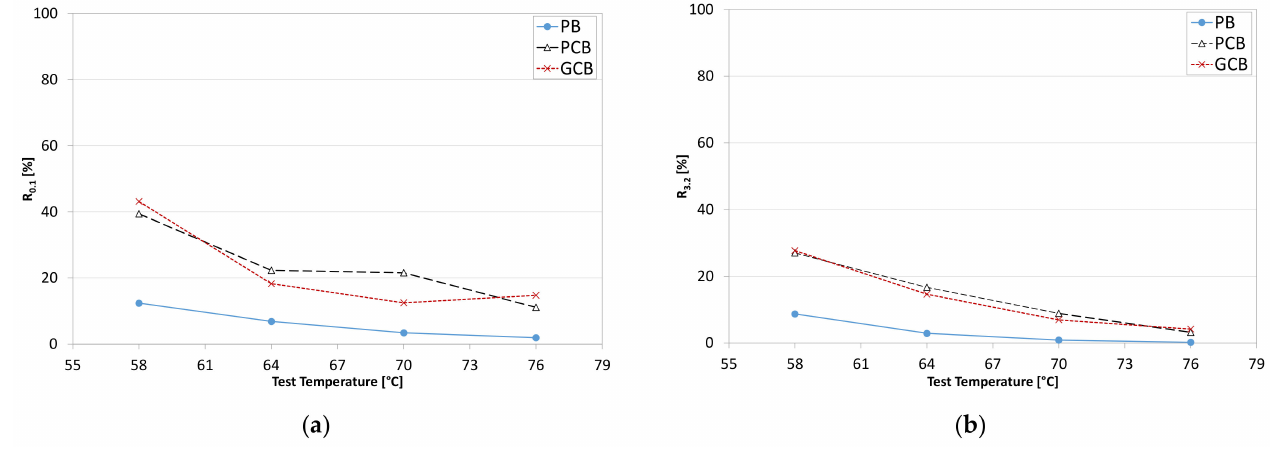
Figure 15. Average percent recovery R of the three blends: ( a ) at 0.1 kPa; ( b ) at 3.2 kPa.